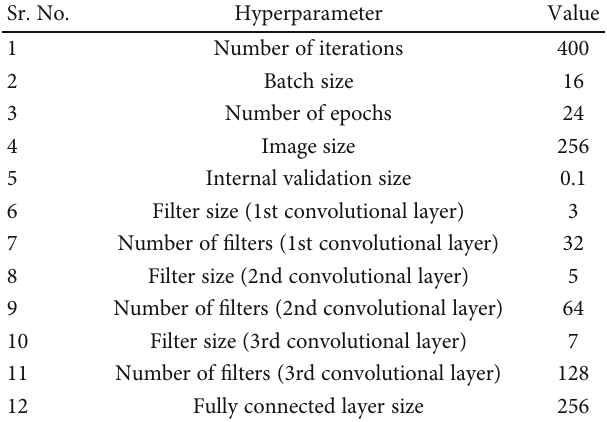
Table 2: Hyperparameters used to train CovidPred models. (a) Original images/single augmentation-based models (for 26 models)